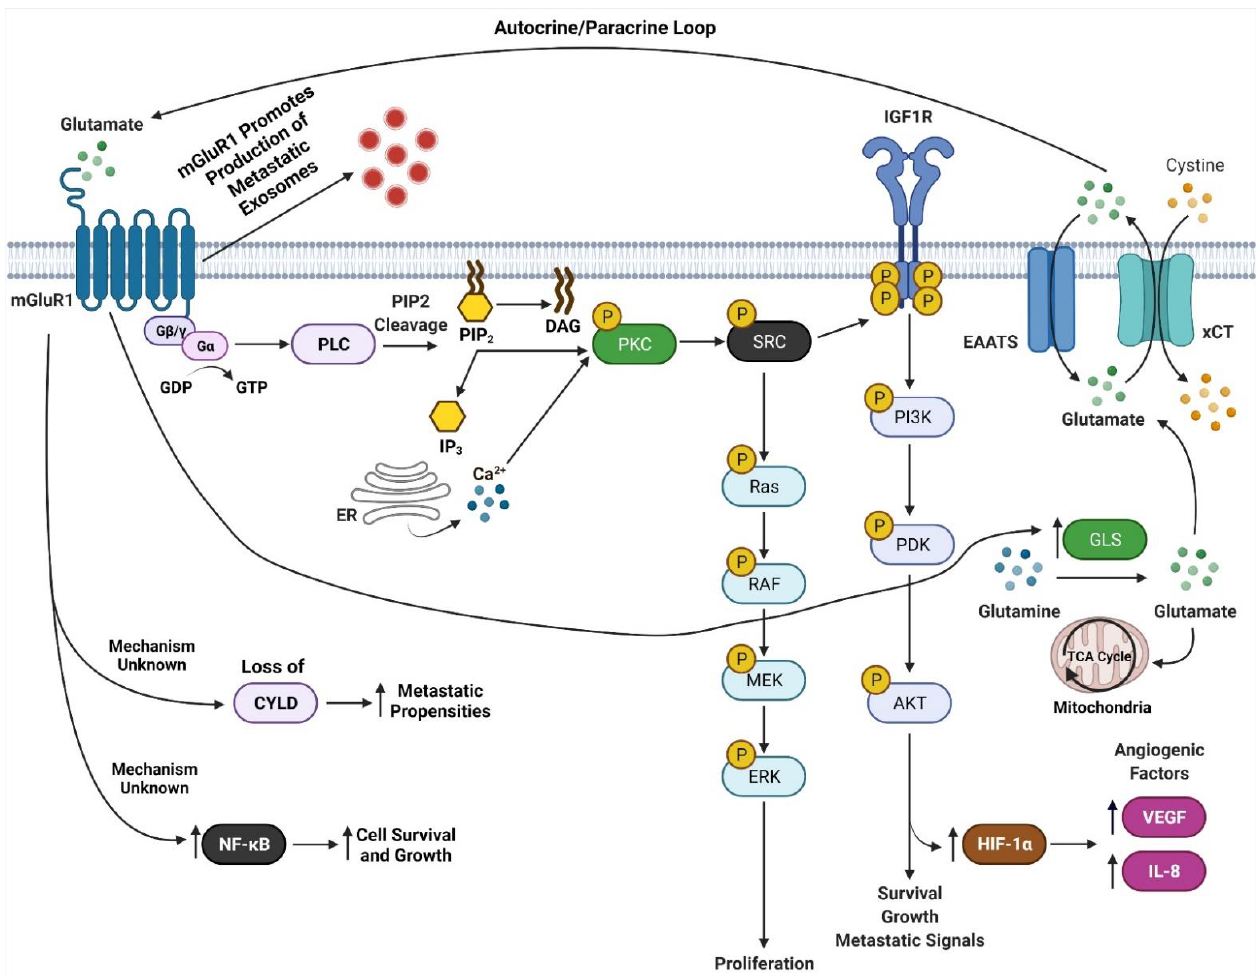
Figure 4. mGluR1 Signaling in Melanoma. Adapted from “Glutamate Signaling Pathways in Melanoma and Potential Therapeutic Intervention Points”, by BioRender.com (accessed on 1 July 2021). Retrieved from https://app.biorender.com/biorender-templates (accessed on 1 July 2021).